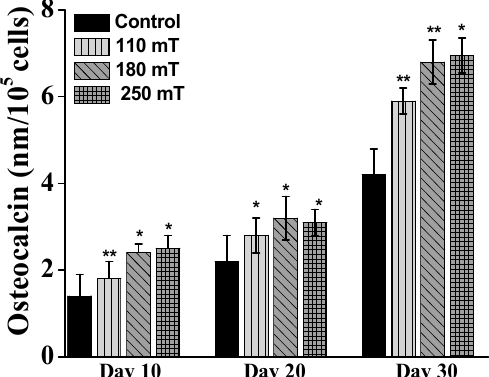
Figure 10. Absorbance measurements for the Osteocalcin secretion from MG-63 osteoblast-like cells growing on ellipsoidal multilayered 3D structures having the layers spatially separated by cylindrical pillars, as a function of the applied static magnetic fields. Results for unstimulated samples (controls) are shown for comparison. Each bar represents the mean ± STD. Statistical significance was determined by Student’s t -test (* p ≤ 0.05, ** p ≤ 0.001).